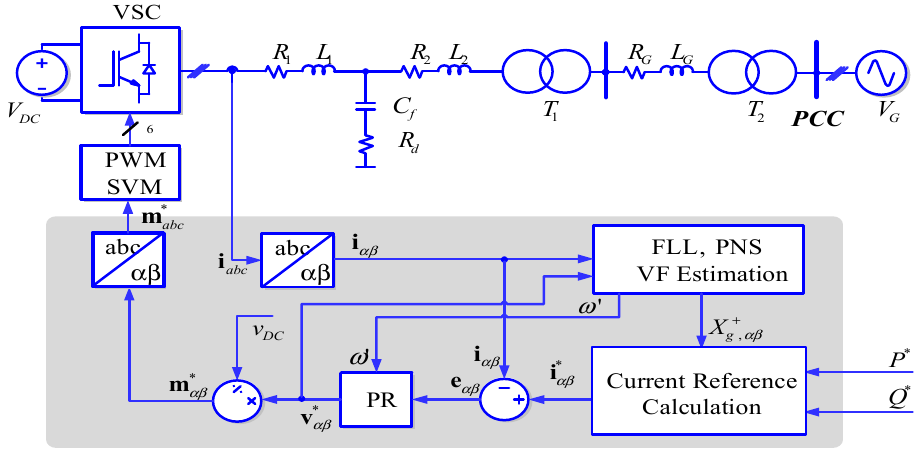
Figure 10. Structure of the study case considered for the simulation and the experimental validation.